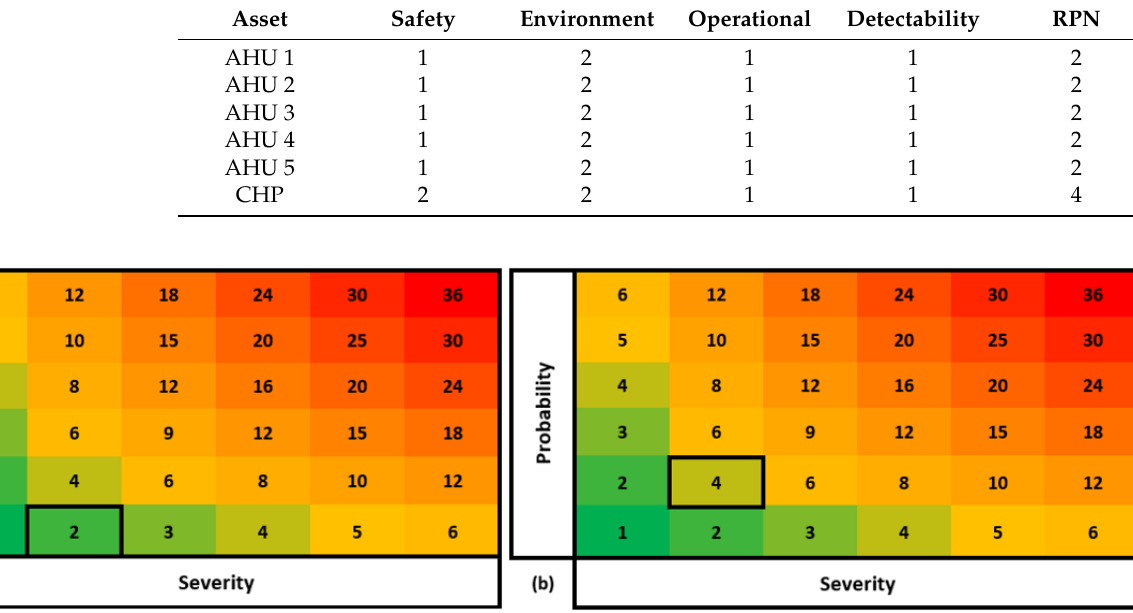
Table 6. Risk priority number assessment of selected assets categorised as level 1. Asset